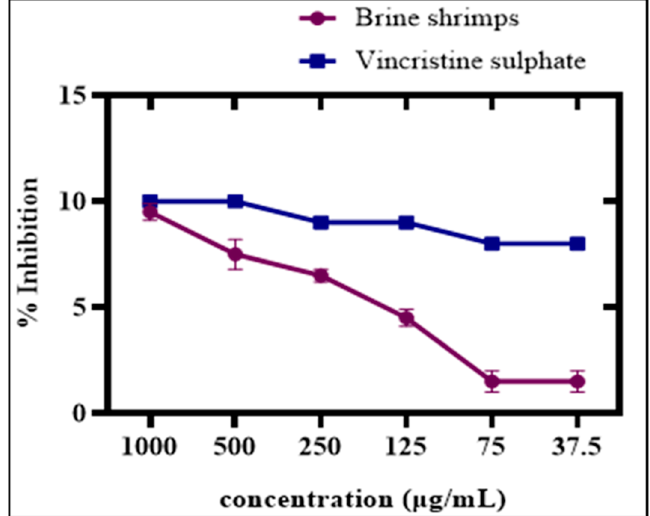
Figure 8. Cytotoxic effects of P.A mediated Ag 2 ONPs on brine shrimp.